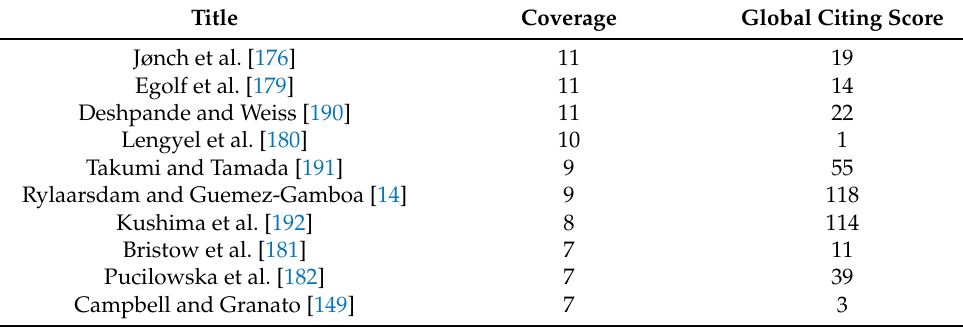
Table 12. Top 10 citing papers in Cluster #9 identified using